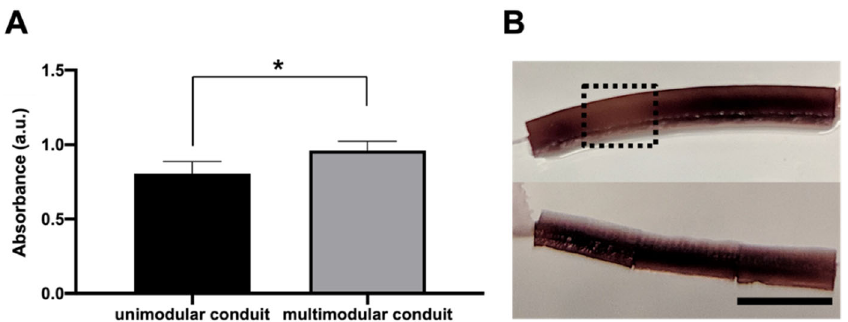
Figure 4. Differences of Schwann cells density between unimodular and multimodular conduits after 5 days. ( A ) MTS assay on SC cultured for 5 days inside unimodular and multimodular conduits. In multimodular conduit cell proliferation was increased. An asterisk * indicates statistically significant differences, indicating a p -value below 0.05. ( B ) Macroscopical view of hydrated ( top ) unimodular and ( bottom ) multimodular conduits after MTS assay (reveled with color brown). Zone without cellular continuity in unimodular conduit is indicated with a black dash lines box. Scale bar: 6